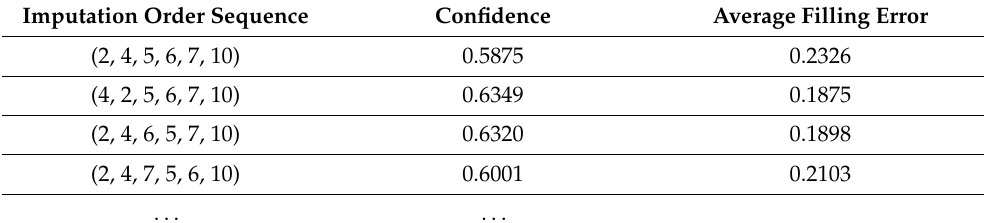
Table 5. Part of filling order and its confidence.